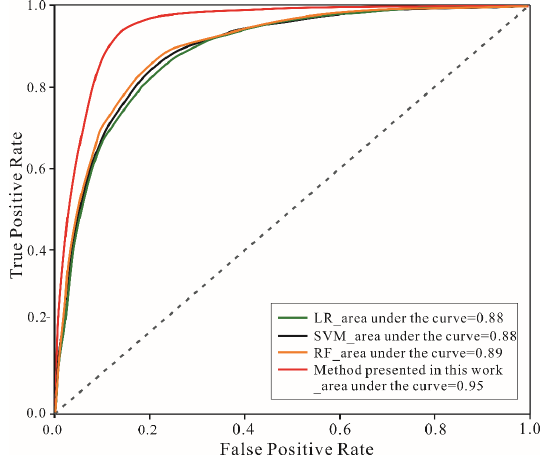
Figure 9. ROC for binary classification.